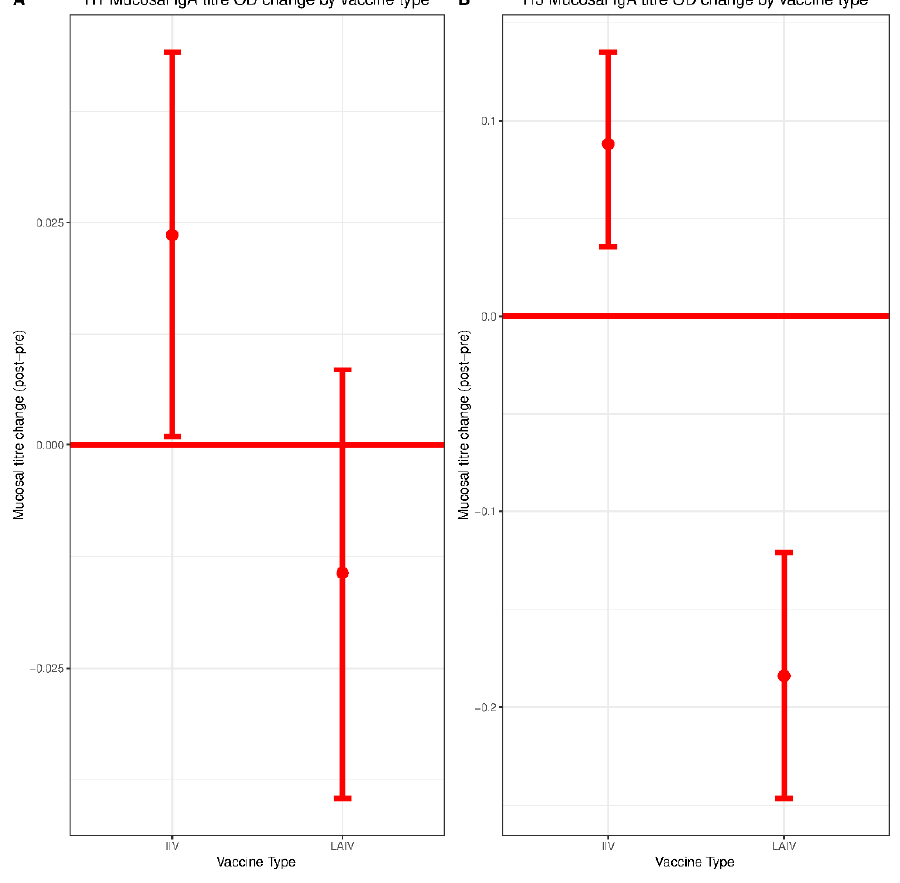
Figure 3. H1 and H3 pre / post-vaccination mucosal IgA titer change by vaccine type. ELISA assays were performed to measure titers of mucosal IgA collected by nasal swab using ( A ) recombinant Cal / 09 H1 protein or ( B ) recombinant Tex / 50 H3 protein. Normalized optical density from pre-vaccination to post-vaccination were plotted for each vaccine formulation. LAIV, n = 340; IIV, n = 278. Significance of mucosal IgA titer change within each vaccine group was evaluated by paired Student t test. Di ff erences between vaccine groups (IIV vs. LAIV) were assessed using Mann–Whitney U